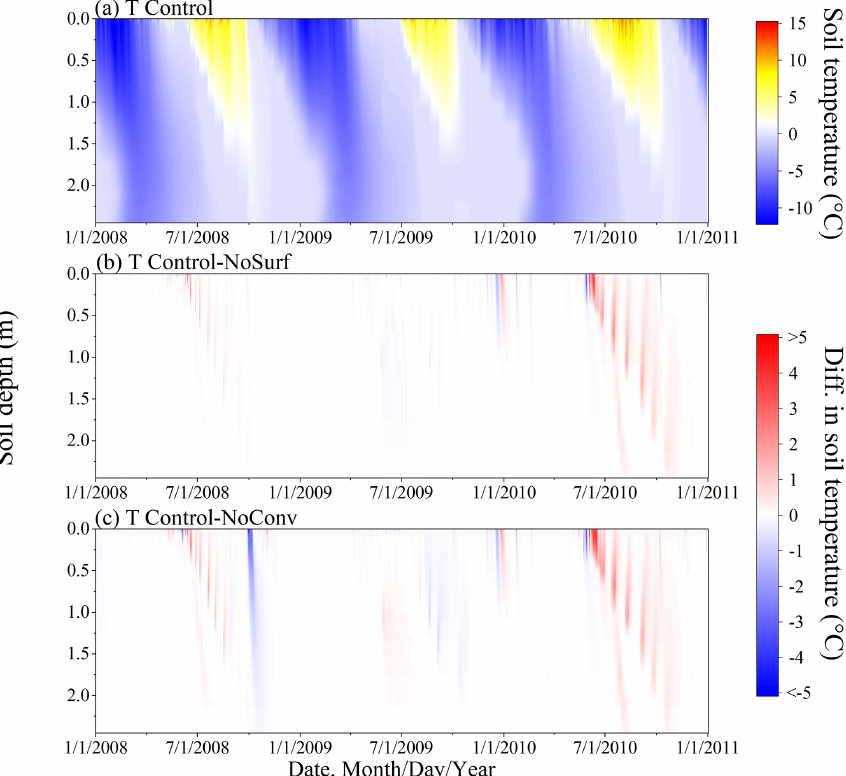
Figure 4. Simulated hourly ground temperature profiles under the Control scenario (a) , as well as the differences in soil temperature between the following scenarios: Control–NoSurf (b) and Control–NoConv (c) . Control, NoSurf, and NoConv represent full, partial, and no consid- eration of convective heat transfer (CHT) in the SHAW model, respectively. NoSurf removes CHT due to infiltration, and NoConv removes all CHT processes from the